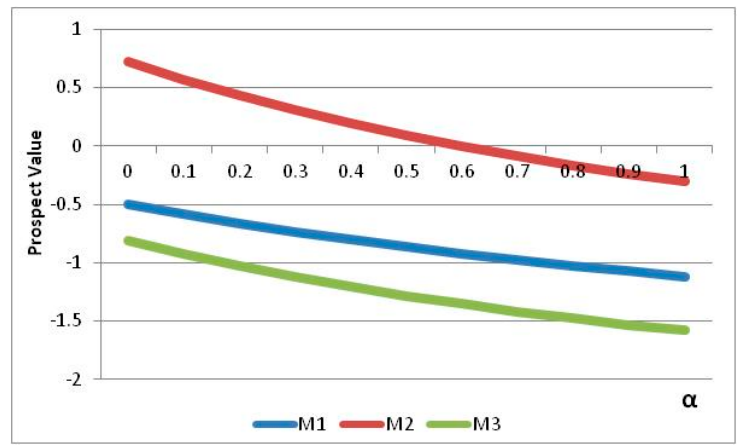
Figure 3. The integrated prospect values of three micro-grid planning programs with different λ values.